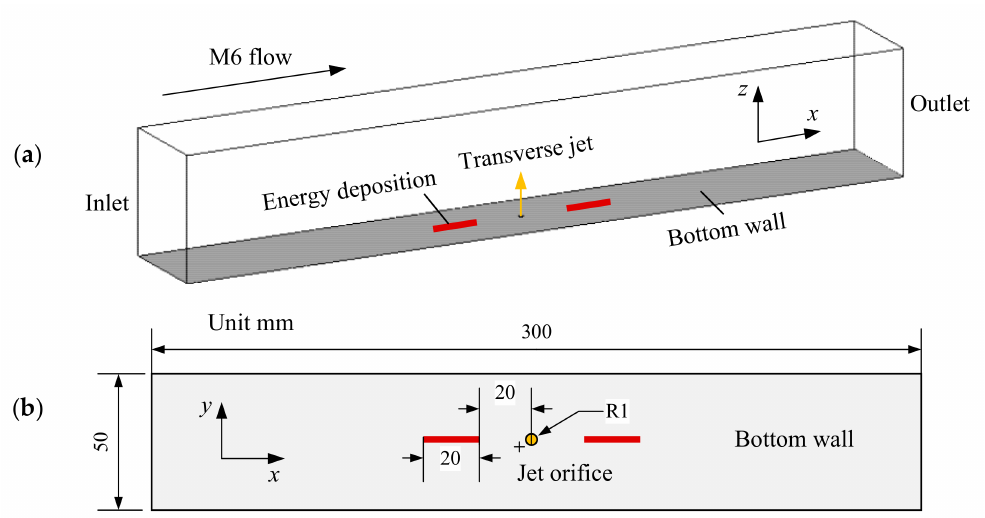
Figure 1. Schematic diagram of the physical model for the numerical simulations: ( a ) Overhead view and ( b ) primary